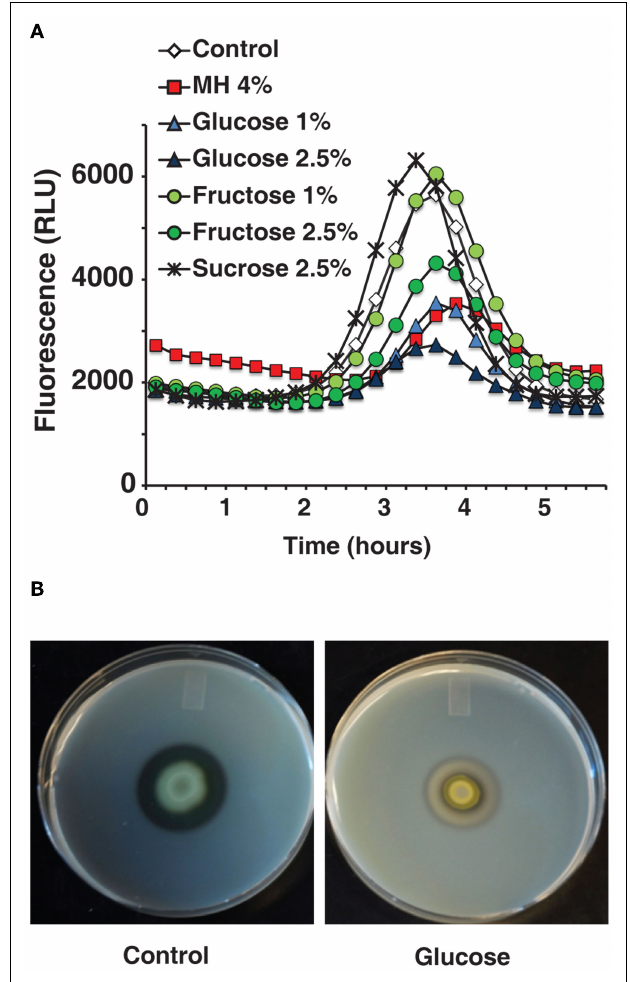
FIGURE 3 |The effects of honey on QS-related genes and virulence factors can be reproduced by comparable sugar solutions. (A) Indicates that the inhibitory effect of diluted honey on pqsA can be reproduced using sugar solutions. (B) Shows the effect on extracellular proteases caused by 2.5% glucose in milk